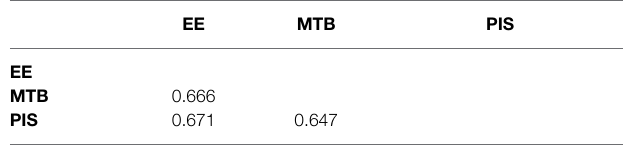
TABLE 3 | Discriminant validity: Fornell–Larcker criterion. Constructs